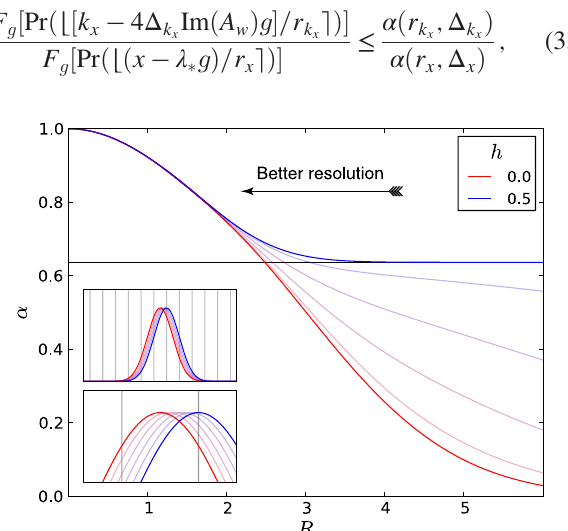
FIG. 2 Numerically obtained relationships between relative Fisher information α and inverse resolution R . The different curves (blue to red; top to bottom in the main figure and right to left in the inset) correspond to different alignments that are schematized in the insets. The worst and best cases at h ¼ 0 and h ¼ 0 . 5 , respectively, are shown in bold. Aside from misalign- ment effects (which become important when R ≳ 3 ), finite resolution does not dramatically limit parameter estimation. In fact, with only two pixels, the penalty paid is only a loss of about a third of the information, as long as good alignment is possible. The curves are equally relevant for the standard strategy or the WVA